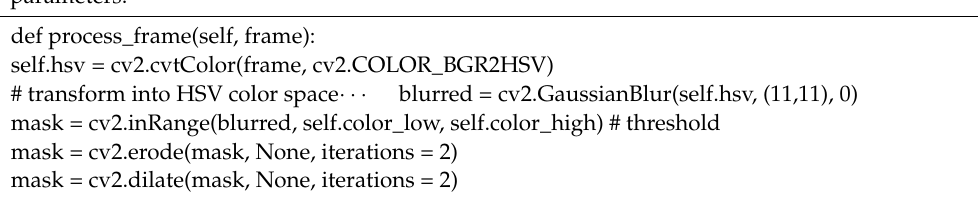
Algorithm 2. Fragment of the Python code: other conversion function with associated